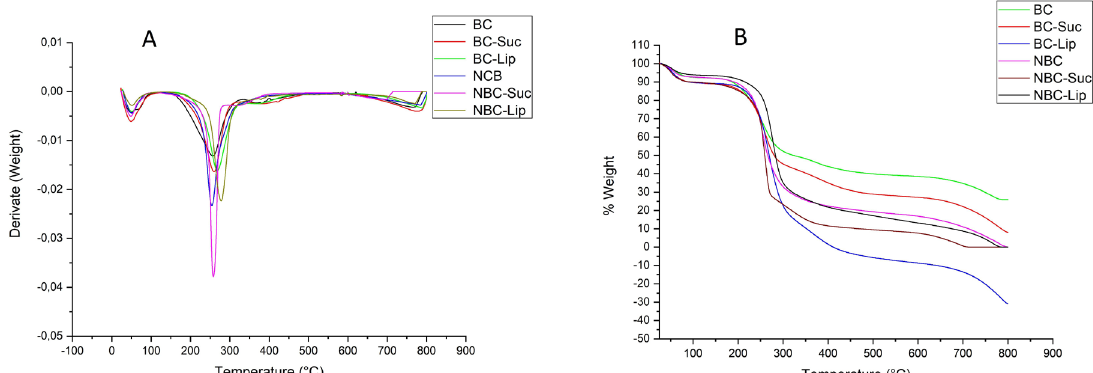
Figure 6. TGA curve of the cellulose membrane and the native, succinylated and immobilized lipase (a) nanocellulose; DTG curve of cellulose membrane and pristine, succinylated and immobilized lipase (b)